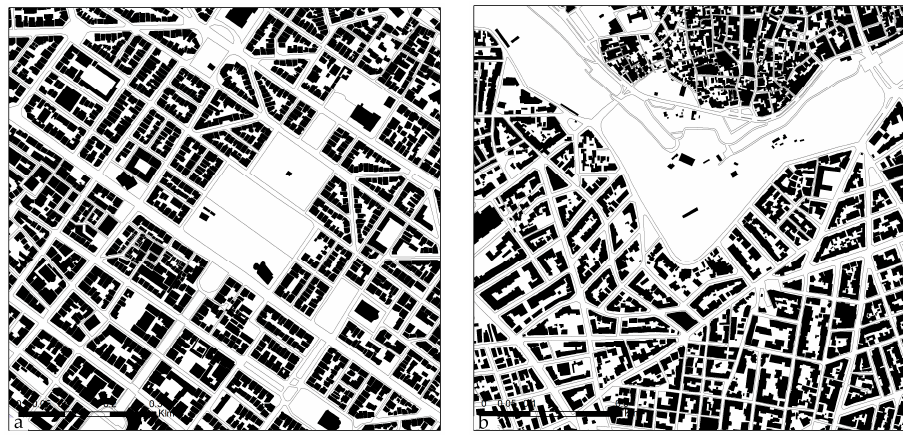
Figure 4. The urban tissue of the two cities. ( a ) Urban blocks layout configuration for the city of Thessaloniki; ( b ) Urban blocks layout configuration for the city of Heraklion [35].